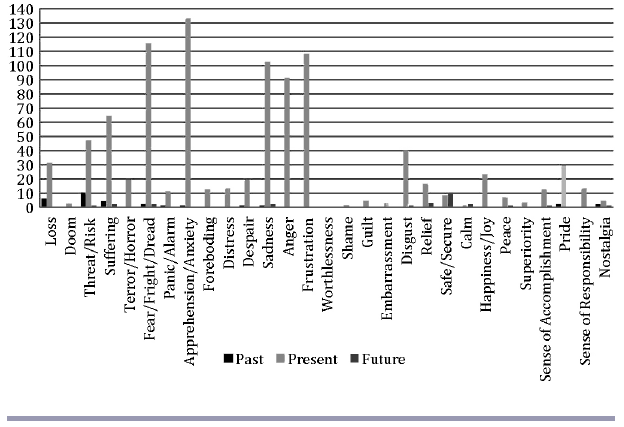
Fig. 3. Emotion counts between 24 May 2000 and 15 October 2000.